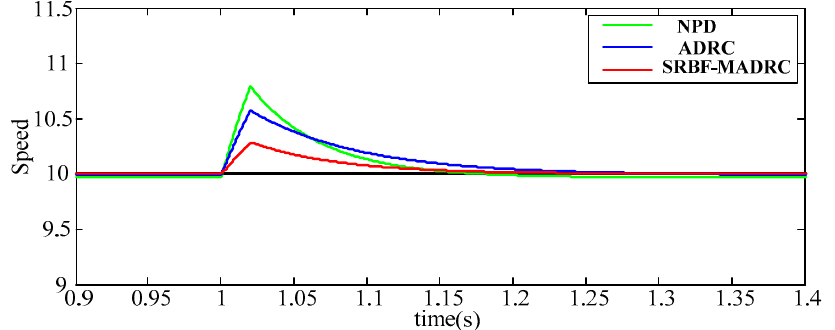
Figure 11. Simulation results of interference pulse.